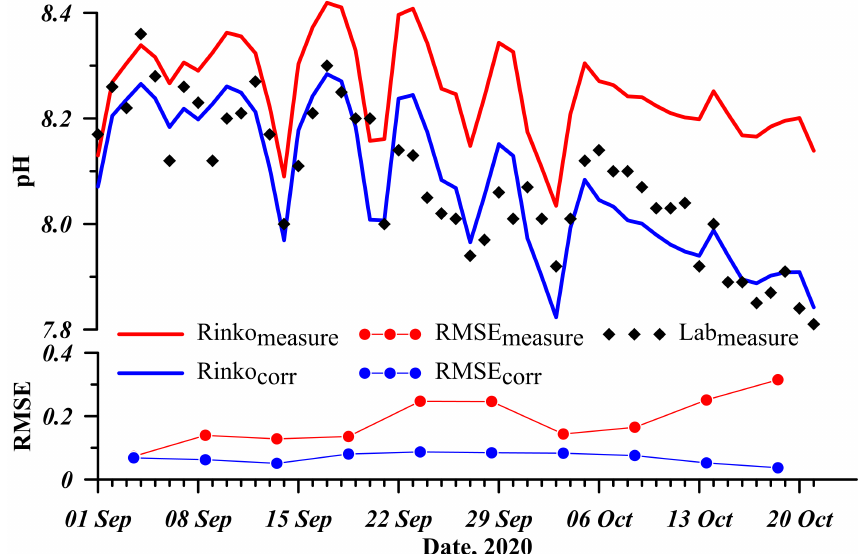
Figure 4. Correction of the pH sensor data based on the laboratory